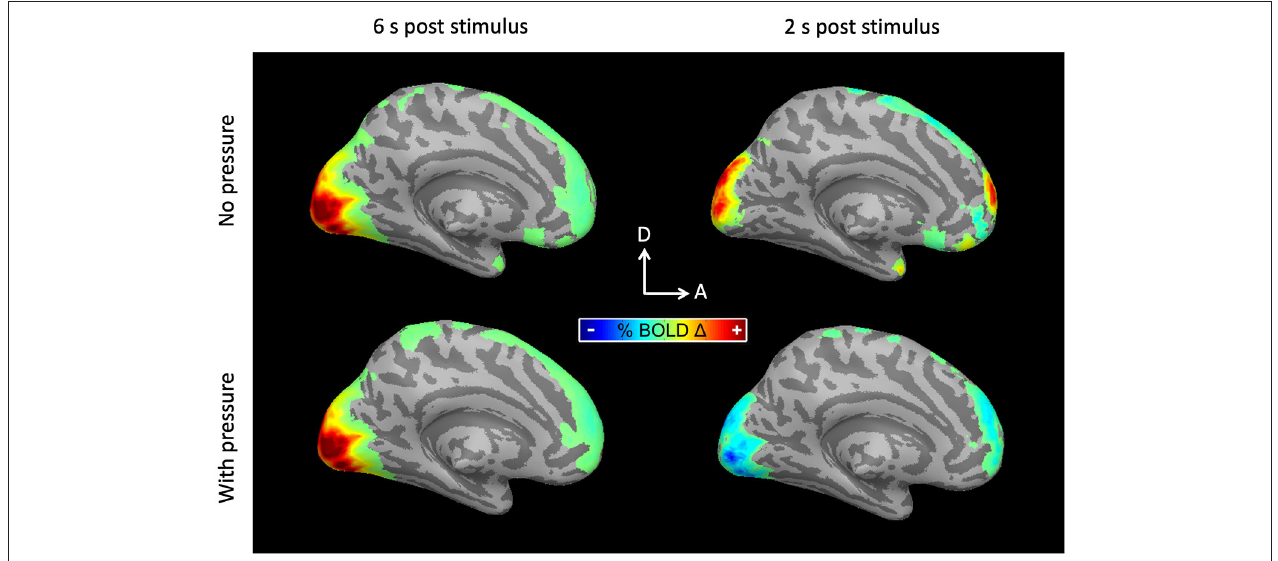
FIGURE 4 | BOLD activations for the majority group average. (Left) 6s post stimulus onset. PVC was activated (responded positively) to moving dot stimuli. The activation was similar for both Ac and SpAc emphasis. (Right) 2s post stimulus onset. Both PVC initial dip activity and mPFC suppression were enhanced with SpAc emphasis.